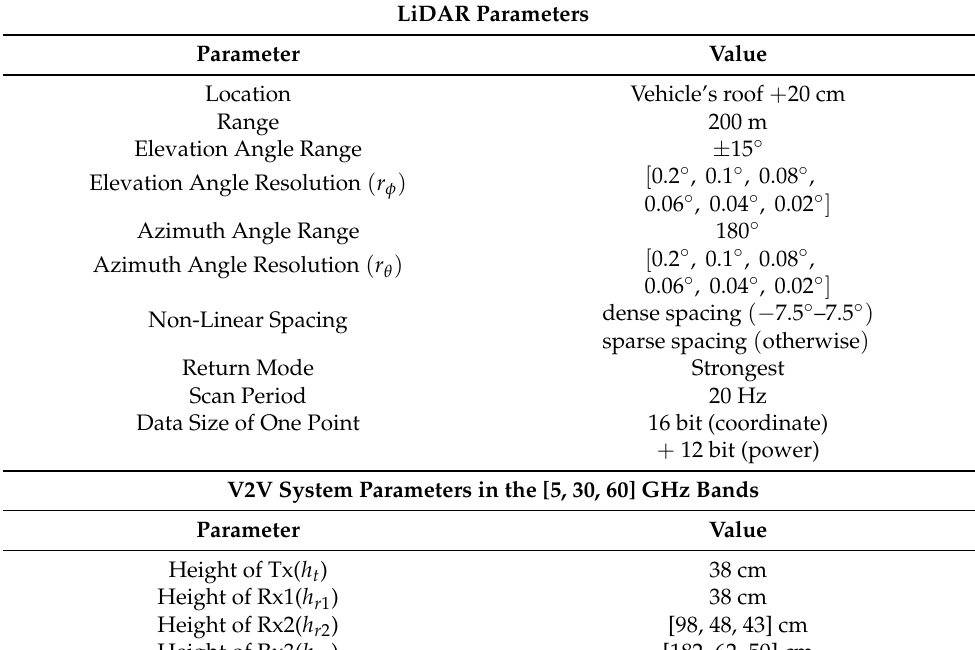
Table 1. Simulation